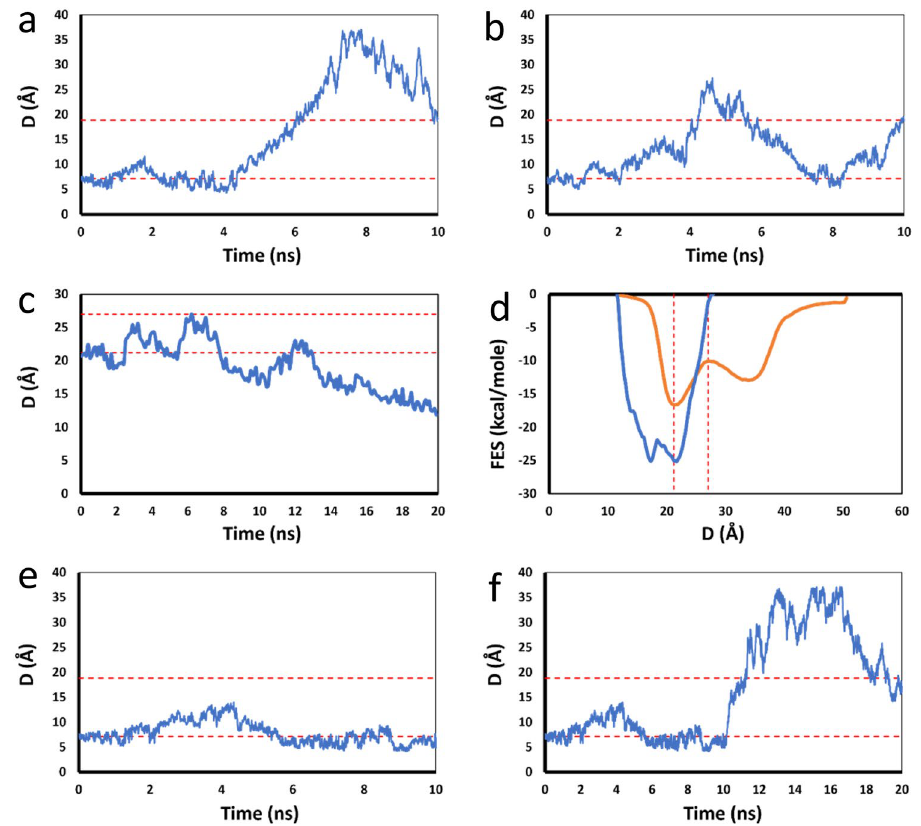
Figure 3. Examination of each run against one-way trip description. ( a ) D versus Time plot of a one-way trip run in which the sampling initially stays around r 0 (lower-level dotted red line), and then goes up passing through r b (higher-level dotted red line) without returning back to the level around r 0 . ( b ) D versus Time plot of a multi-trip run in which the sampling goes up passing through r b and then returns back to the original level around r 0 . ( c ) D versus Time plot of a run where D goes toward opposite direction of dissociation signaling invasions, conformational changes or other movements unrelated to the dissociation. ( d ) Average FES (orange curve) and the primitive FES (blue curve) corresponding to the run in panel ( c ). The primitive FES of this run invades the “inner” region, left to the left wall of the primary minimum of the average FES. ( e ) D versus Time plot of a run that stays in the bound state because the simulation time is not long enough. ( f ) D versus Time plot after the run in panel e is extended to longer simulation time, showing a one-way trip